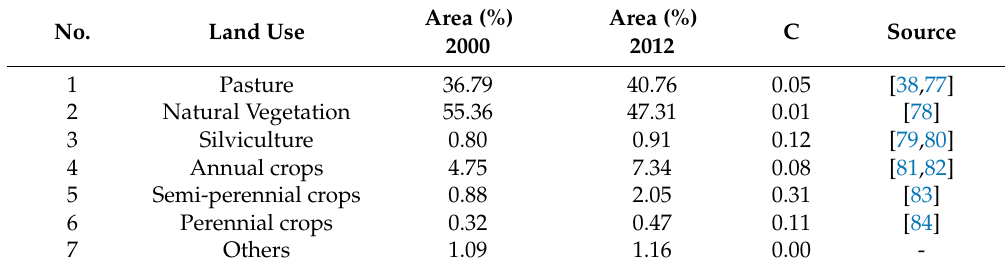
Table 4. Values of the cover management factor (C) for each land use cover class of the Brazilian Cerrado.